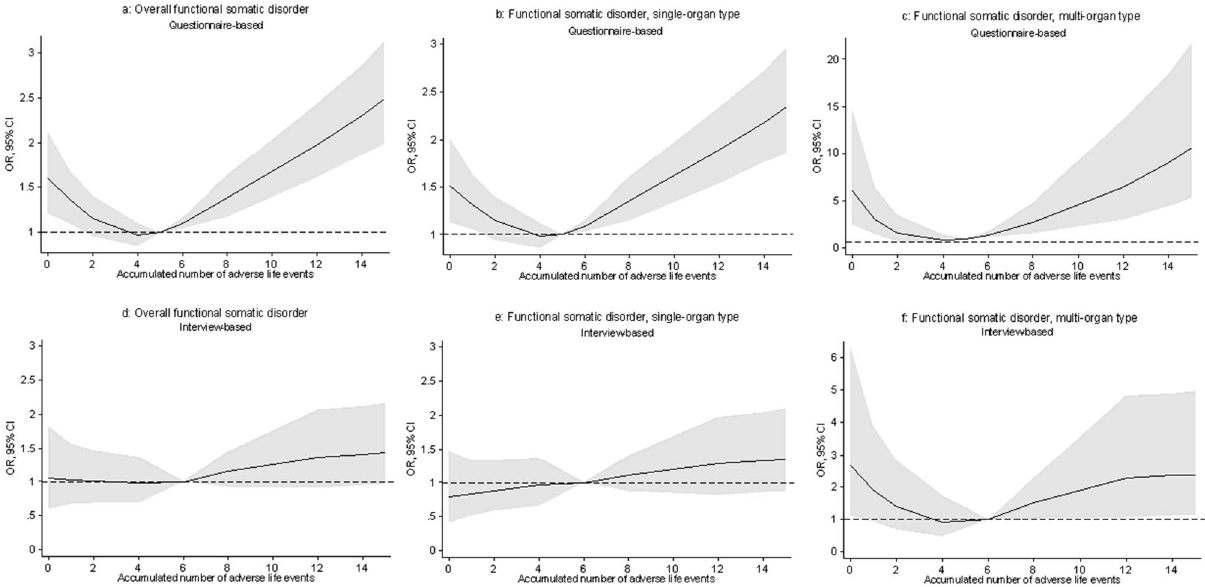
Figure 1. Association between the accumulated number of adverse life events and functional somatic disorders. Cases were established by means of both self-reported questionnaires and diagnostic interviews. ( a,b,d,e ) were adjusted for sex, age, social status, personality, and self-efficacy. ( c,f ) Were only adjusted for sex because of low number of cases. NB! The OR scales for the multi-organ types ( c,f ) have different ranges than the OR scales for the other